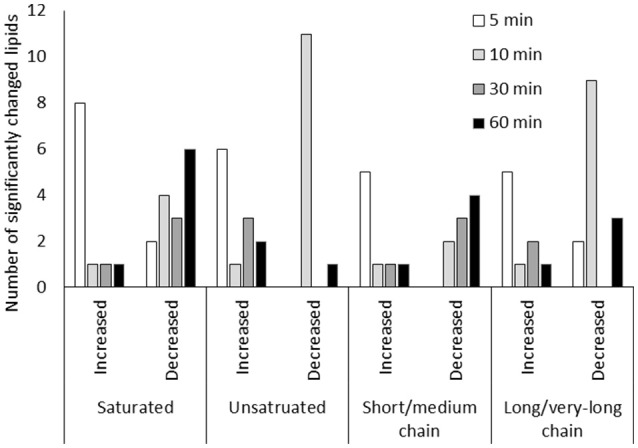
Lipid metabolic changes in guard cells under low CO2. Short/medium chain lipids include lipids of 5C-14C lipids. Long/very-long chain lipids include lipids with carbon chains longer than 16C. Only lipids that showed significant changes (p < 0.05) were included.